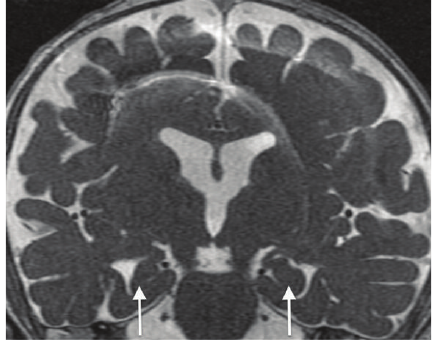
Figure6:CoronalFIESTA-C(repetitiontimemsec/echotime,10/4) demonstrating malrotation of the hippocampal heads